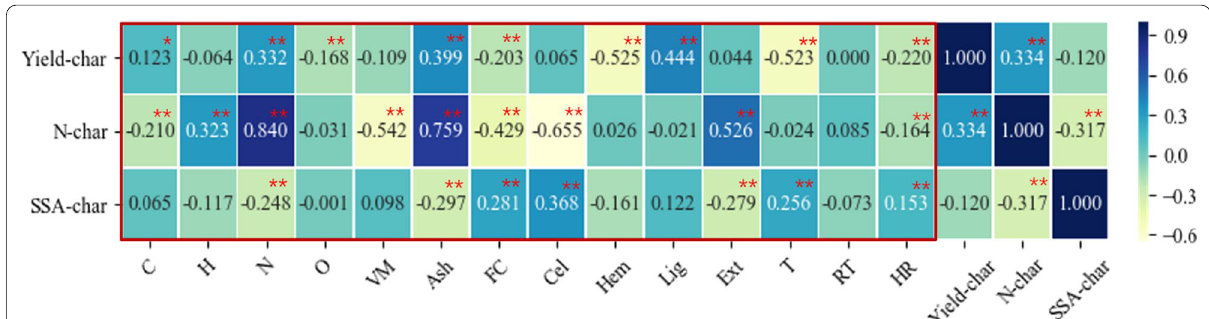
Fig. 1 Heatmap about characteristics of biomass and biochar through Pearson coefficient analysis based on the whole data collection of 400 pieces of data (* means p-value < 0.05 and ** means p-value <